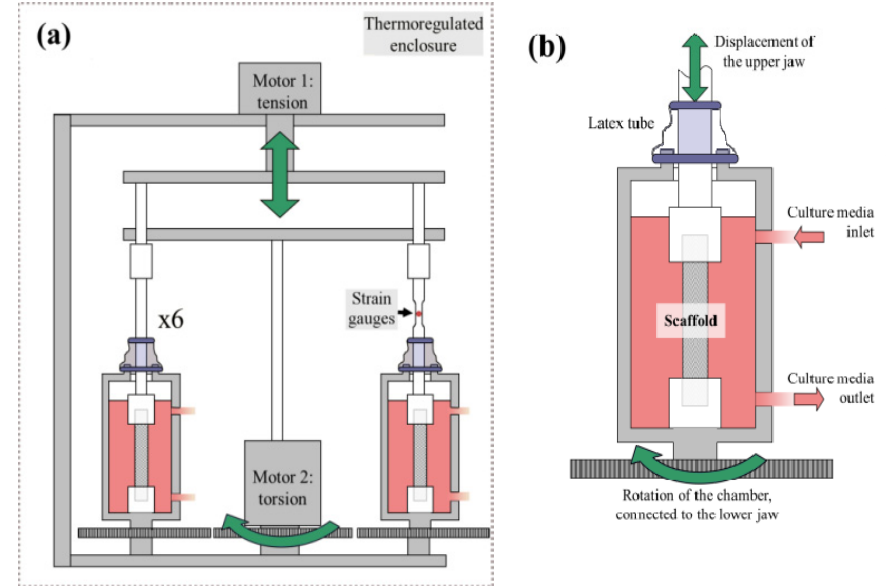
Figure 1. ( a ) Global scheme of the bioreactor functioning ( b ) Zoom on one of the six bioreactor